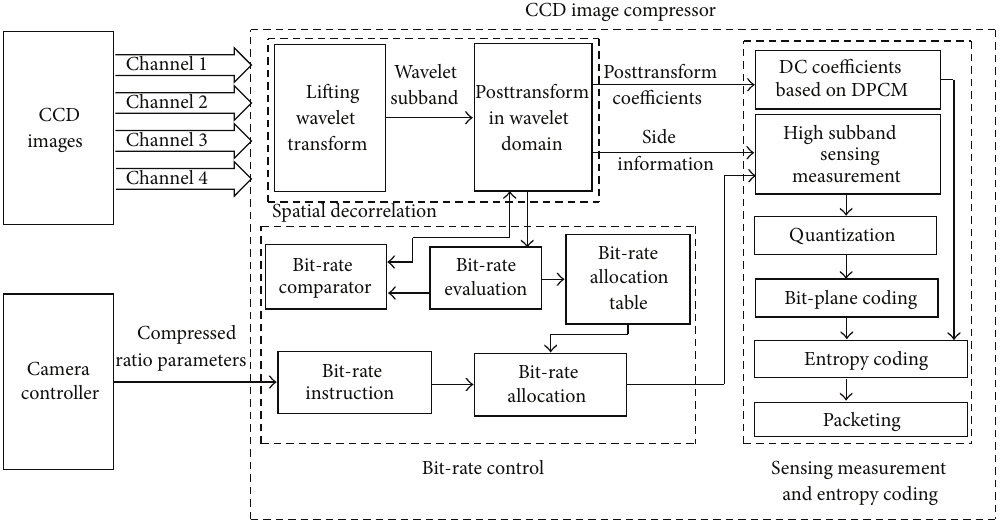
Figure 14: Compression algorithm architecture for CCD image using the proposed PT-CS method.